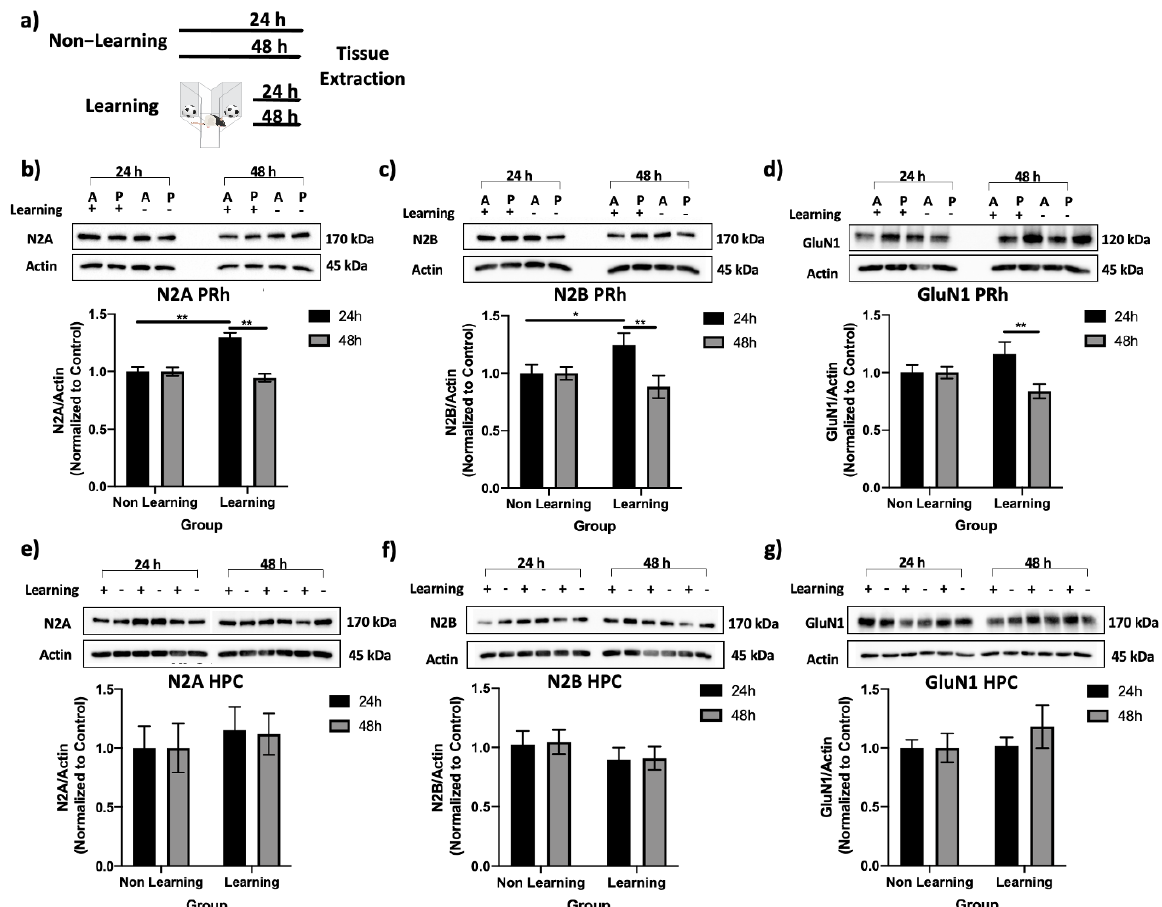
Figure 7. GluN2A, GluN2B, and GluN1 levels are significantly greater 24 h following learning compared to 48 h in PRh